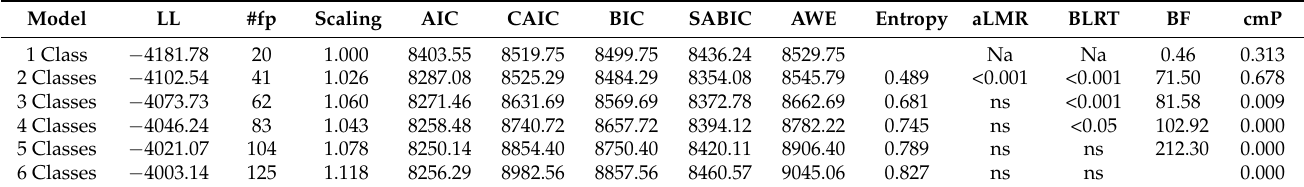
Table 2. Class description and indexes of the latent class analysis.